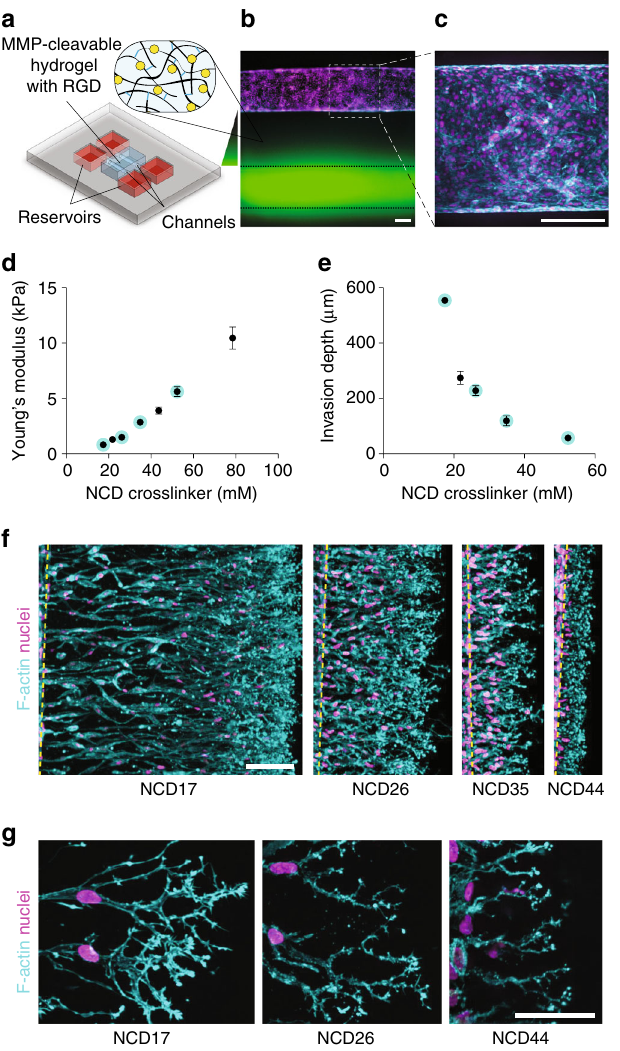
Fig. 3 Angiogenic sprouting is in fl uenced by matrix crosslinking.